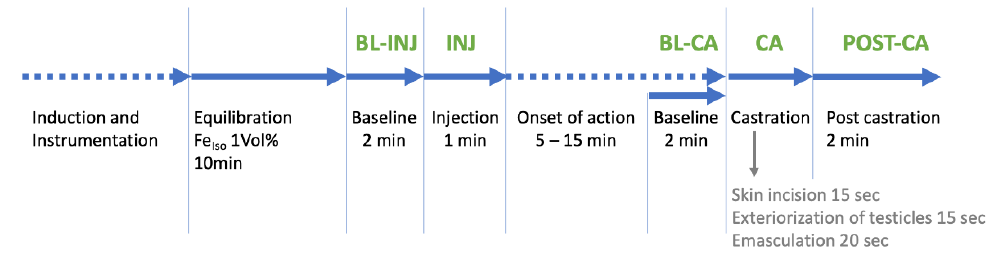
Figure 1. Timeline of the experimental procedure. Dotted arrows indicate time segments with variable length. Abbreviations of analyzed timepoints are green. variable length. Abbreviations of analyzed timepoints are